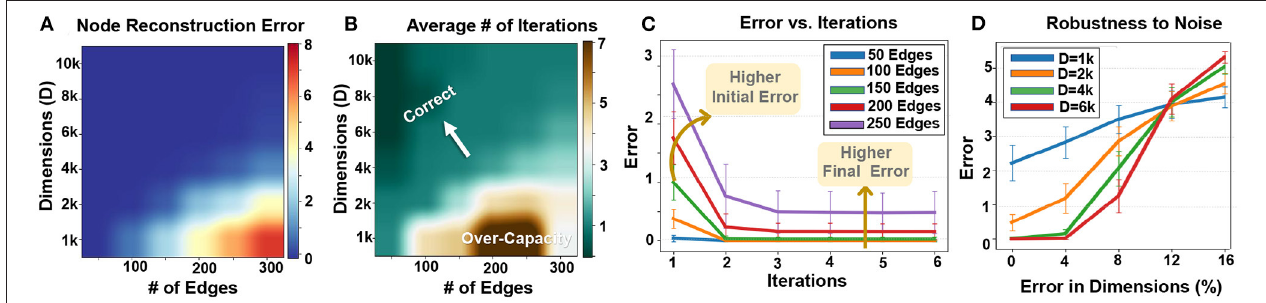
FIGURE 11 | Node memory reconstruction: (A) error rate, (B) required iterations vs. graph size and dimensions, (C) error rate vs. iterations, and (D) robustness to